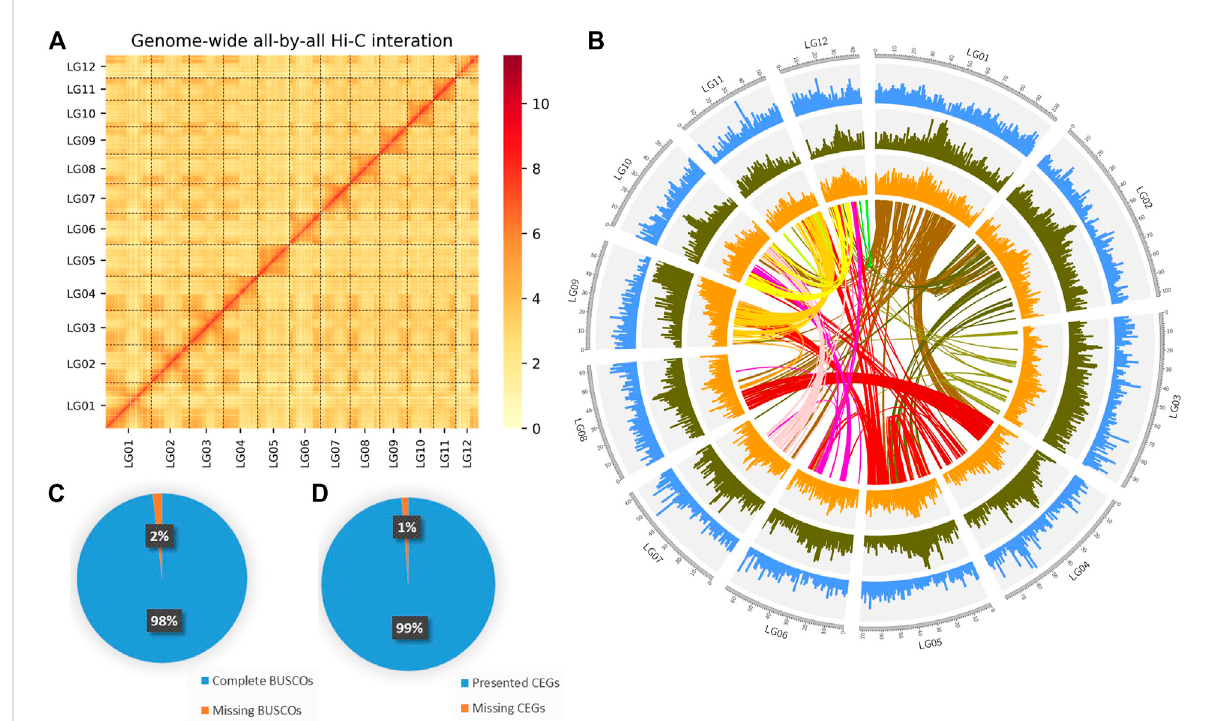
FIGURE 2 Genome assembly of DXWR. (A) The genome contig contact matrix. The blocks indicated the contacts between linkage groups, color depth indicated the degree of contacts. (B) Circos plot of genomic features. The tracks from the outermost to innermost are: chromosome, gene